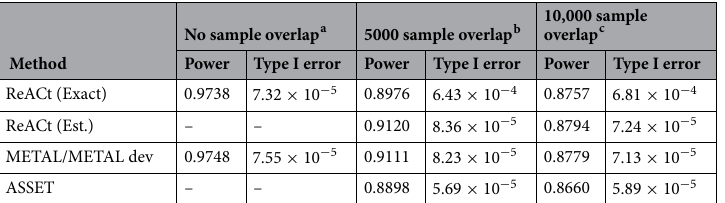
Table 1. Performance of fixed-effect meta-analysis on simulated data using the gcta model. Using the simulated phenotypes for UK biobank samples (50,000 cases and 250,000 controls), we compared the performance of our method vs. ASSET/METAL. We treated genome-wide significant SNPs ( p -value 8 10 < 5 ) as “true signals”, and reported average power and type I error rates on identifying those SNPs − × under the same genome-wide significance threshold for each method. METAL dev refers to the latest release in GitHub 28 . Two variants of ReACt are tested: Exact and Est, indicating whether the sample overlap was exactly known as part of the input or whether it was estimated , respectively. Sample overlap indicates the number of cases and controls that were shared between two input studies, i.e., 5000 sample overlap means that 5000 cases and 5000 controls were shared between the two studies when the split was carried out. a With 25,000 cases and 125,000 controls from each subset. b Out of 27,500 cases and 127,500 controls from each subset. c Out of 30,000 cases and 130,000 controls from each subset.